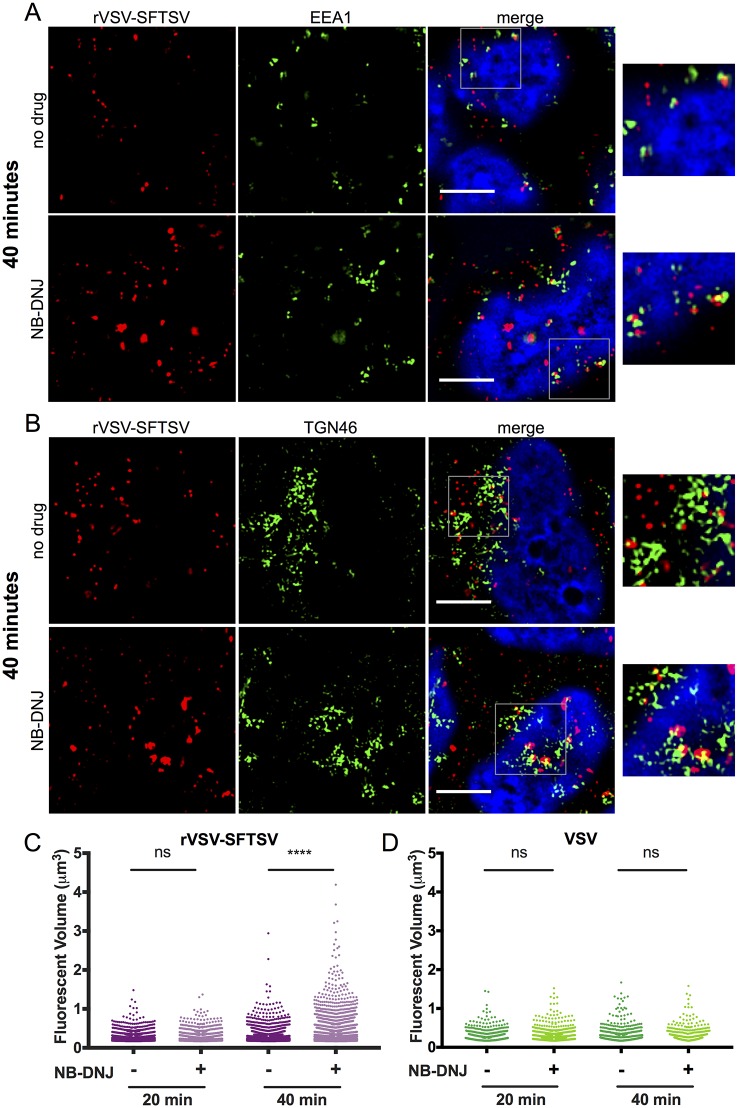
Immunofluorescence microscopy and quantification of incoming virus particles.(A, B) A549 cells prepared as described in Fig 8 were fixed 40 minutes post-warming and co-stained for rVSV-SFTSV (red) and the early endosome marker EEA1 (green) (A) or TGN46 (B). Cells were treated with NB-DNJ (bottom panels) or left untreated (top panels). Boxes indicate zoomed-in regions. Scale bar represents 5μm. (C, D) Quantitative image analysis was performed to measure the volume of discrete VSV M-stained puncta within z-stack images in untreated and NB-DNJ treated cells at both 20 and 40 minutes post-warming. Puncta were counted for at least 6 independent z-stacks per sample for both rVSV-SFTSV (C) and VSV (D) infected cells. (**** p<0.0001 using Welch’s one-tailed t-test).